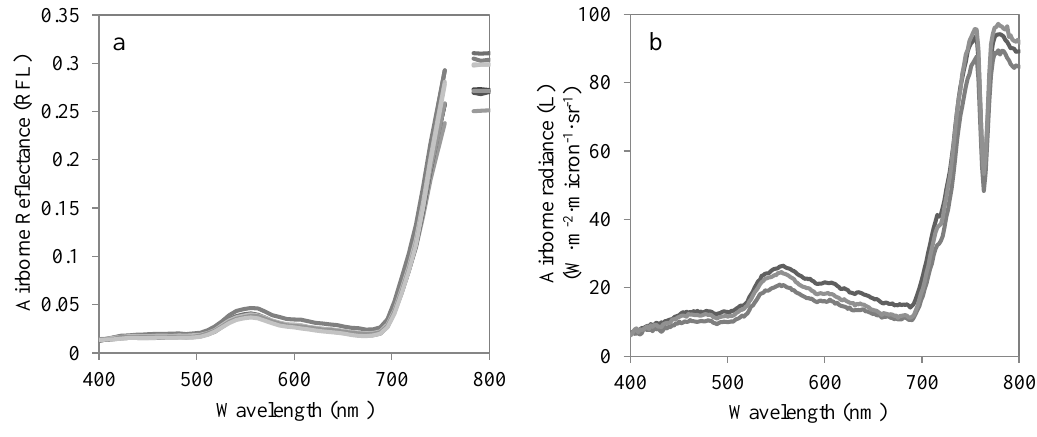
Figure 3. Airborne hyperspectral reflectance ( a ) and radiance ( b ) extracted from pure vegetation pixels obtained on DOY